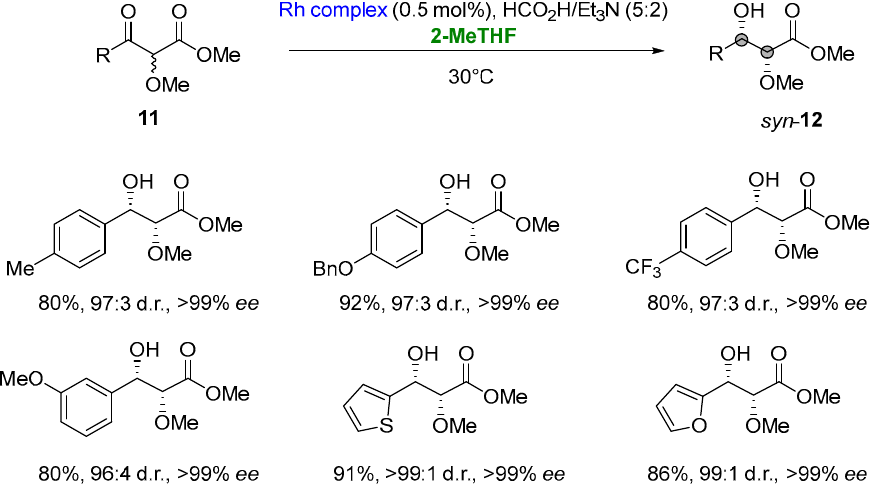
Figure 10. Combined reductive-DKR en route to syn - α -alkoxy β -hydroxyesters.